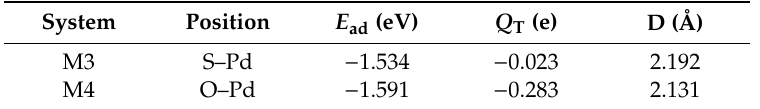
Figure 4. Adsorption structures of SO 2 on Pd 3 -graphene surface (distance in Å). Table 2. Structural parameters of SO 2 adsorption systems on Pd 3 -graphene surface. Position represents the approaching way, for instance, S–Pd means the SO 2 molecule approaches the Pd atom by the S atom.